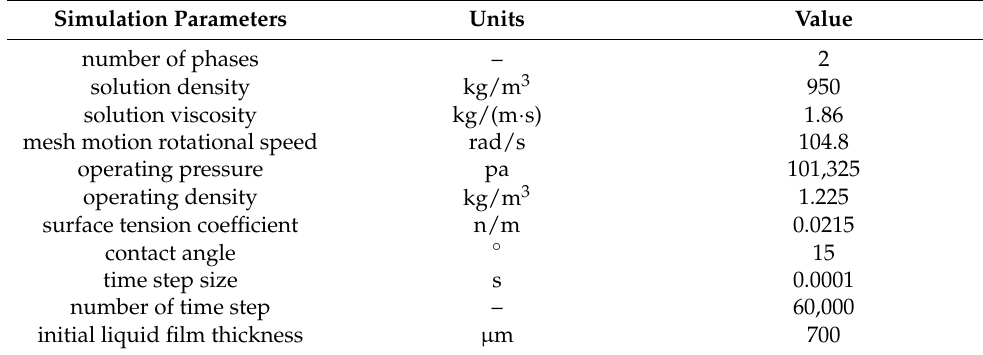
Table 1. Parameters used in the simulation